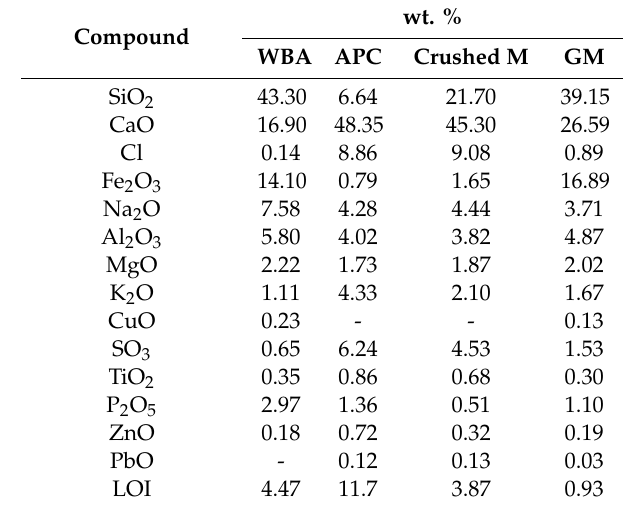
Table 2. Chemical composition determined by means XRF for the WBA, APC, crushed M and the GM